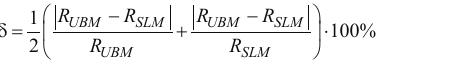
bound analysis (UBM), are higher than corresponding